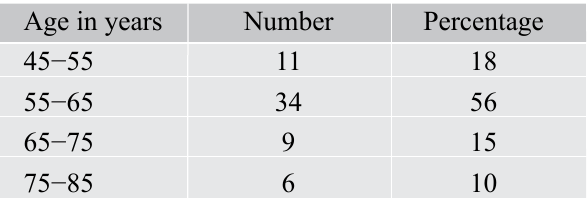
Table 1: Age distribution of study